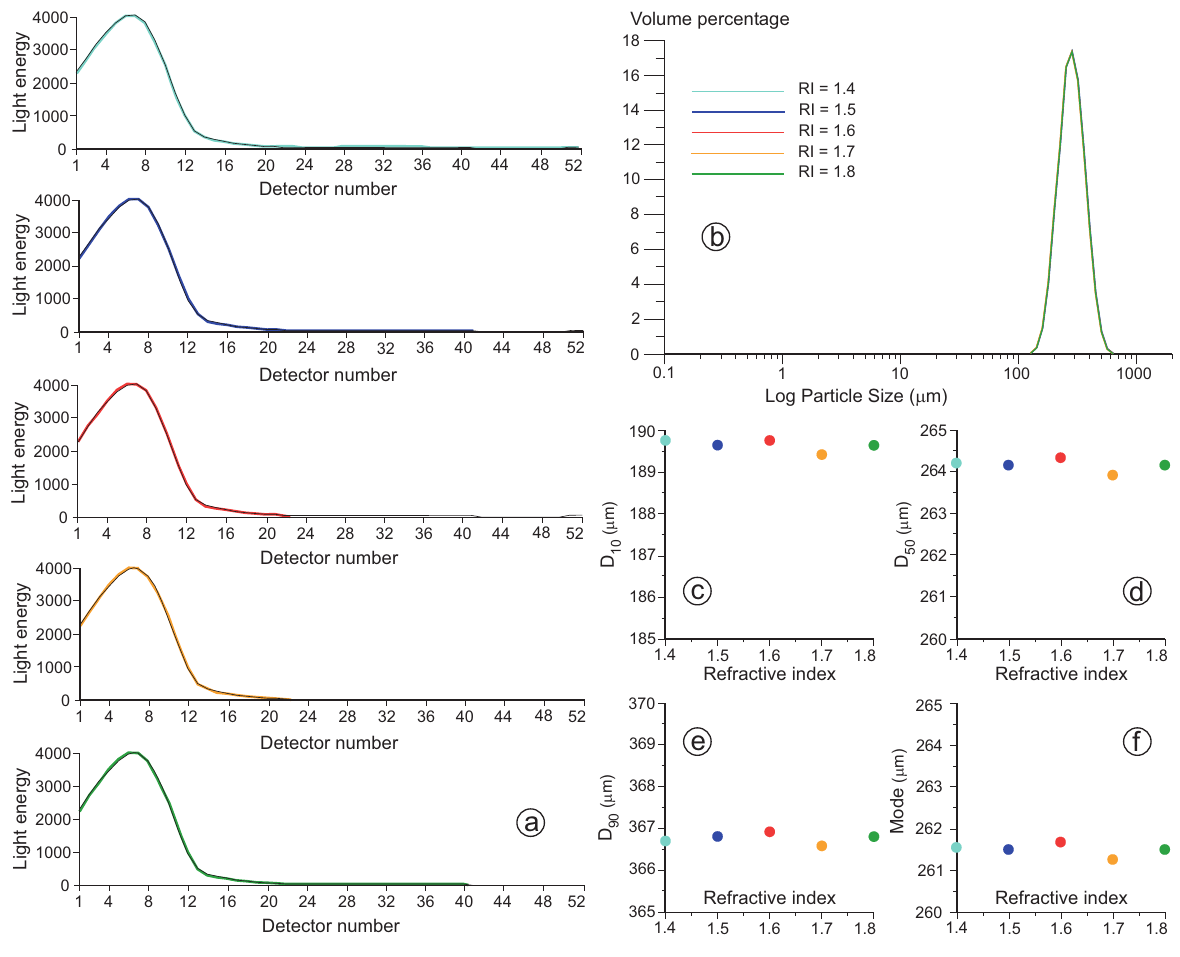
Fig. 20. Reprocessing of the first run data from test MP2500 5 on sub-sample aliquot SAND1c (Fig. 8). (a) Light scattering data (black curve) and corresponding best fits for variable RI values of quartz from 1.4 to 1.8 (colour code in (b)), constant ABS values of quartz=0.1, and constant RI values of decalcified tap water=1.33. (b) Granulometric curves computed from reprocessed data in (a). (c) D 10 percentiles for data in the 5 curves illustrated in (b). (d) D 50 percentiles for data in the 5 curves illustrated in (b). (e) D 90 percentiles for data in the 5 curves illustrated in (b). (f) Modal values for data in the 5 curves illustrated in (b). It is worth noting that changing RI of quartz produces negligible changes in the reprocessed